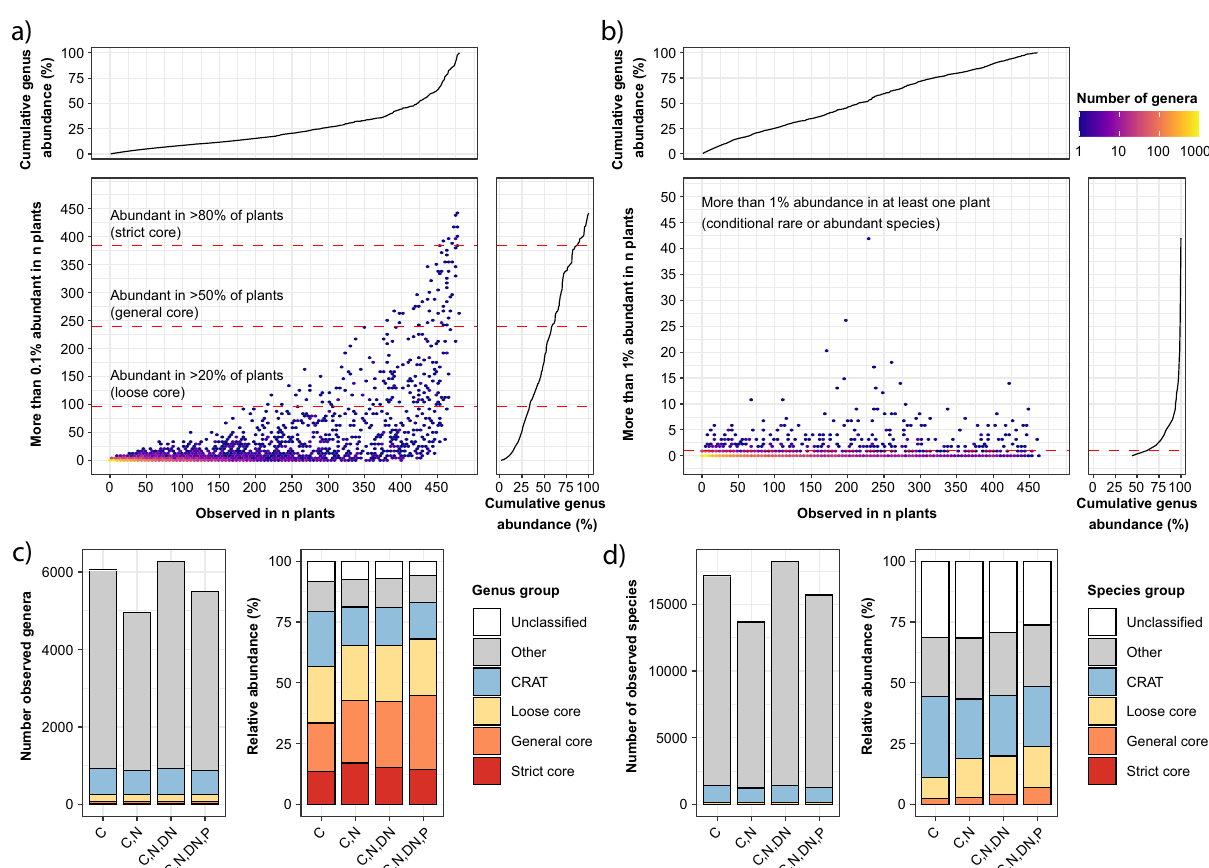
Fig. 6 Identi fi cation of core and conditionally rare or abundant taxa based on V1 – V3 amplicon data. a Identi fi cation of strict, general and loose core genera based on how often a given genus was observed at a relative abundance above 0.1% in WWTPs. b Identi fi cation of conditionally rare or abundant (CRAT) genera based on whether a given genus was observed at a relative abundance above 1% in at least one WWTP. The cumulative genus abundance is based on all ASVs classi fi ed at the genus-level. All core genera were removed before identi fi cation of the CRAT genera. c , d Number of genera and species, respectively, and their abundance in different process types across the global WWTPs. Values for genera and species are divided into strict core, general core, loose core, CRAT, other taxa and unclassi fi ed ASVs. The relative abundance of different groups was calculated based on the mean relative abundance of individual genera or species across samples. C carbon removal, C,N carbon removal with nitri fi cation, C,N,DN carbon removal with nitri fi cation and denitri fi cation, C,N,DN,P carbon removal with nitrogen removal and enhanced biological phosphorus removal